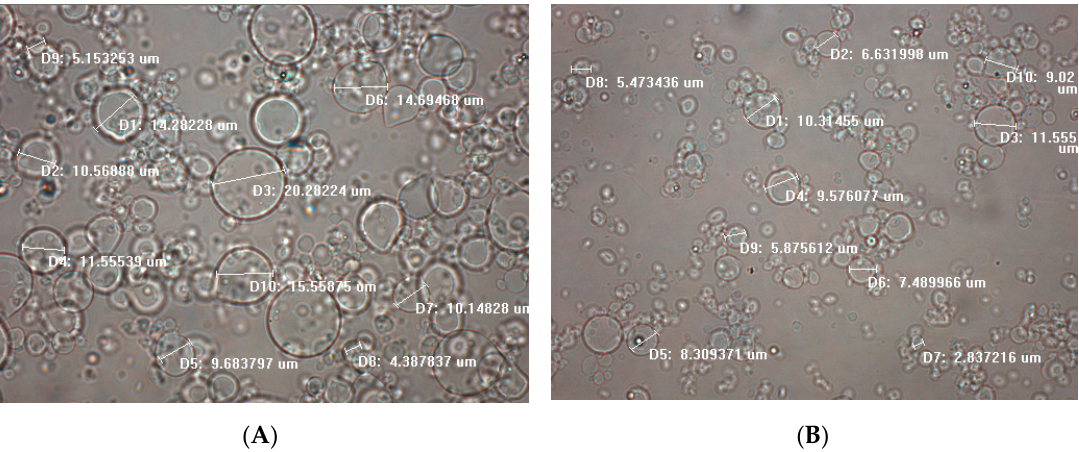
Figure 2. Optical microscopy (60×) of alginate encapsulated Piscirickettsia salmonis antigens. ( A ) picture 1; ( B ) picture 2: ten microparticles were measured in each micrograph with the help of the QCapture Pro 7 TM software.